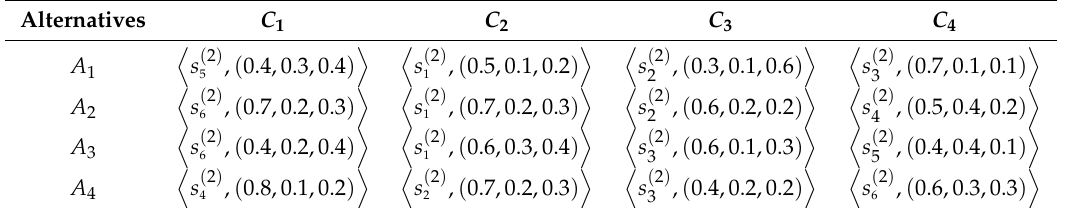
Table 2. SVNL decision matrix D 2 .